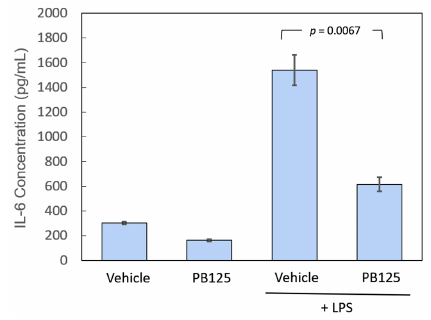
Figure 1. IL-6 protein release is attenuated by Nrf2 activation. HPAECs pretreated with 5 µ g / mL PB125 and then stimulated for 5 h with 20 ng / mL LPS had significantly lower levels of IL-6 released into the culture media than vehicle-pretreated HPAECs stimulated with LPS ( n = 3 in each